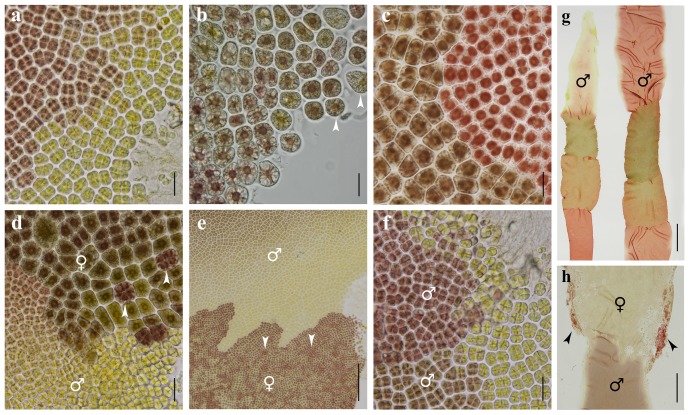
Photomicrographs (a–f) of male and female sectors near the boundary region between two different color sectors in color-sectored F1 blades, and photomacrographs of color-sectored F1blades (g and h), all developed from conchospores of heterozygous conchocelis in the cross between a red mutant (R, ♀) and the wild type (W, ♂) of Pyropia haitanensis.
a. A male near-wild-type sector (W′, ♂) showing spermatangia (yellowish cells). b. A female red sector (R, ♀) and released female gametes (arrowheads) when cultured singly. c. Vegetative cells in a near-wild-type sector (W′, left) and a red sector (R, right). d. A female sector (W, ♀, upper) and a male sector (R, ♂, lower) showing zygotosporangia (arrowheads) and spermatangia (yellowish cells), respectively. e. A male sector (R, ♂, upper) and a female sector (W, ♀, lower) showing spermatangia (yellowish cells) and zygotosporangia (red flecks, arrowheads), respectively. f. Two male sectors (R, ♂, upper; W, ♂, lower) showing spermatangia (yellowish cells). g. Two 4-color-sectored blades showing mature male sectors and immature sectors. h. A female sector (W, ♀, upper) and a male sector (R, ♂, lower) showing red zygotosporangia (arrowheads) and spermatangia, respectively. Scale bars: 20 µm in a–d and f, 200 µm in e, and 0.5 cm in g and h.